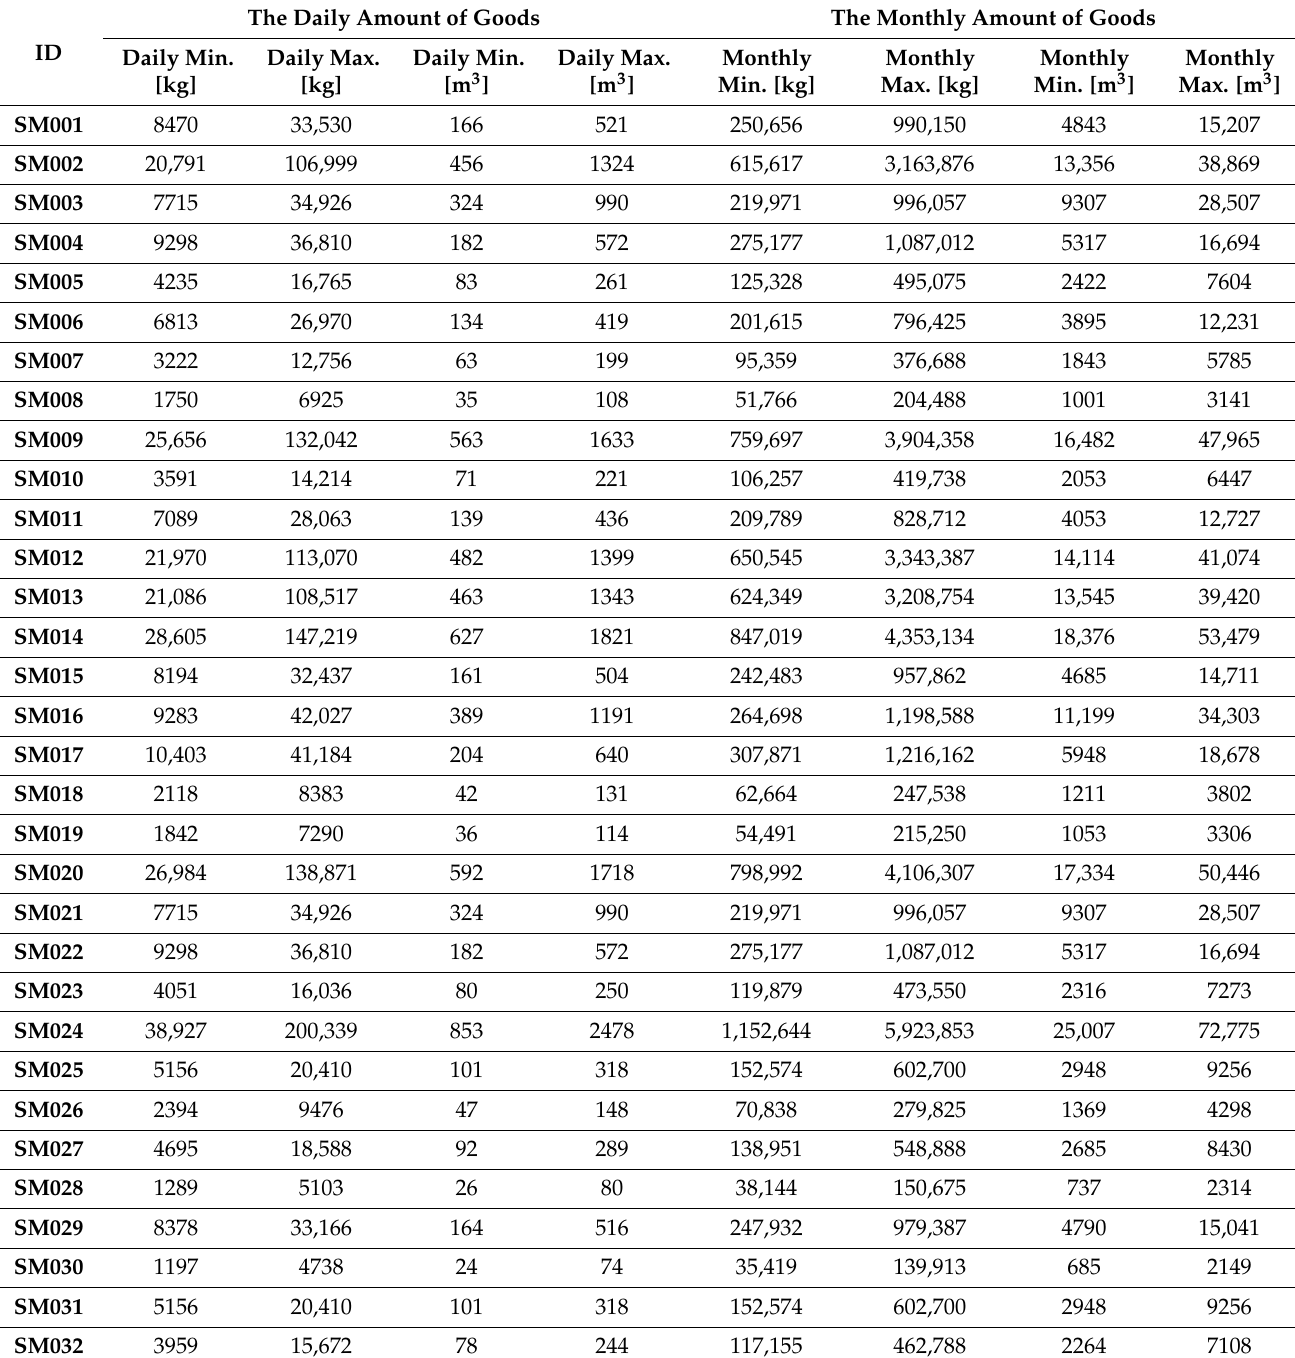
Table A3. Estimated daily and the monthly amount of goods for the examined shopping